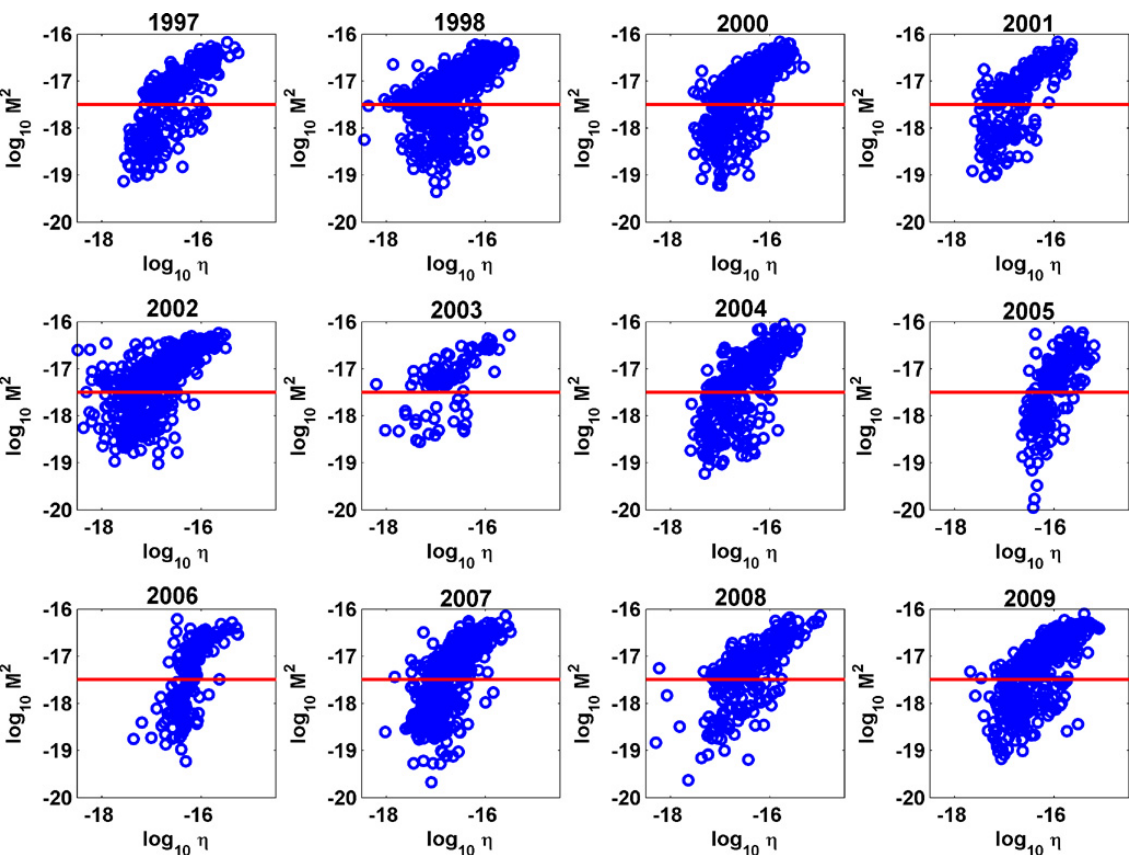
Fig. 1. Scatter plots of the logarithm of the squared refractive index gradient, M 2 derived from radiosonde data against logarithm of radar volume reflectivities, η for altitude range from 8.1km to 13.5km, for the months of June and July.